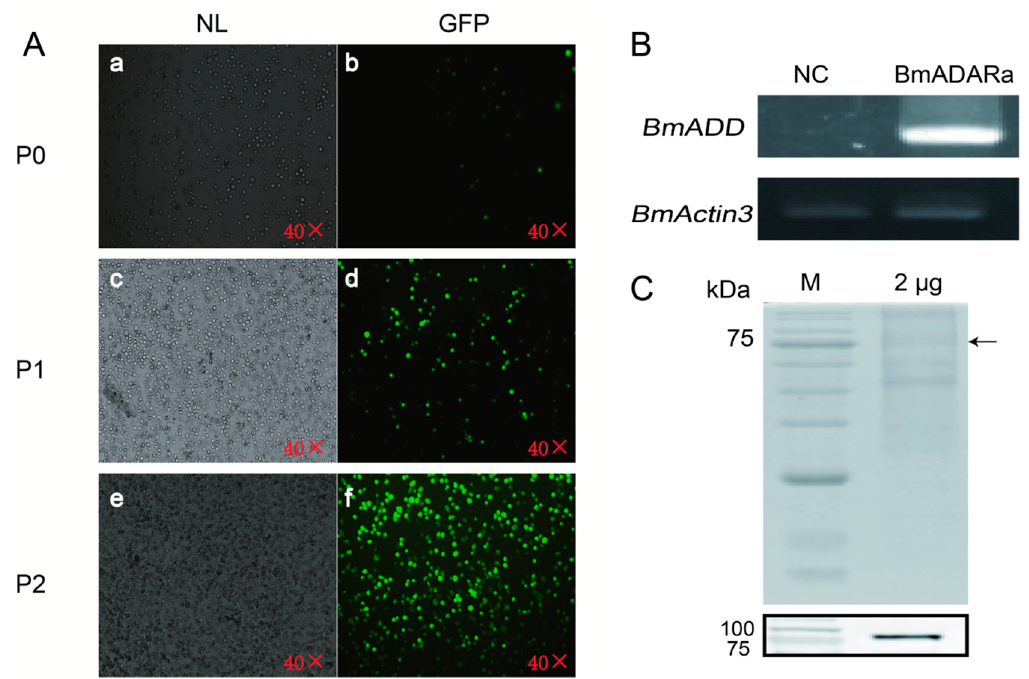
Figure 3. Over-expression and purification of BmADARa in the BmN cells by immunofluorescence ( A ), RT-PCR ( B ), SDS-PAGE and Western blot ( C ). P0, passage 0 virus; P1, passage 1 virus; P2, passage 2 virus. NL, under the normal light; GFP, under the green fluorescence microscope. Transcription of BmActin3 gene was used as a positive control. NC, negative control. Arrow at the right shows the approximate position of BmADARa.